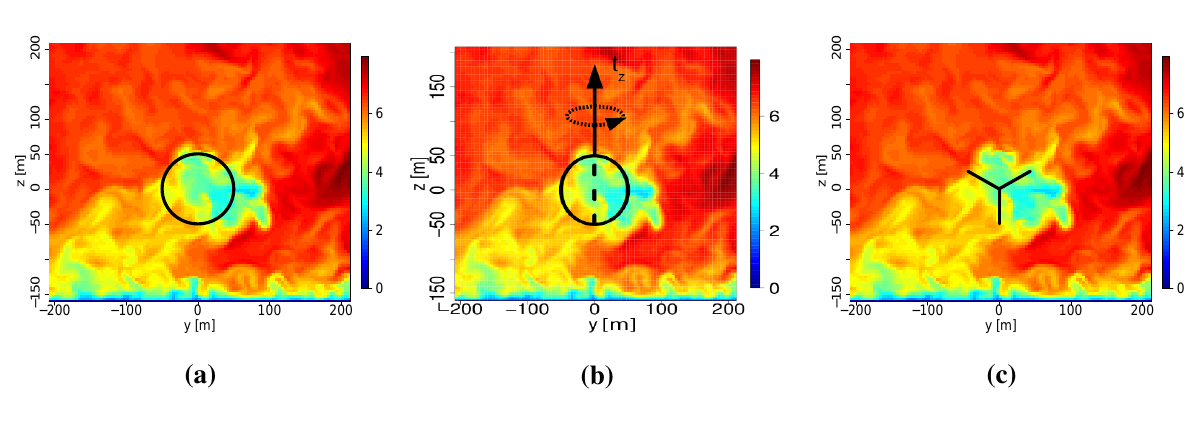
z is related to the torque z